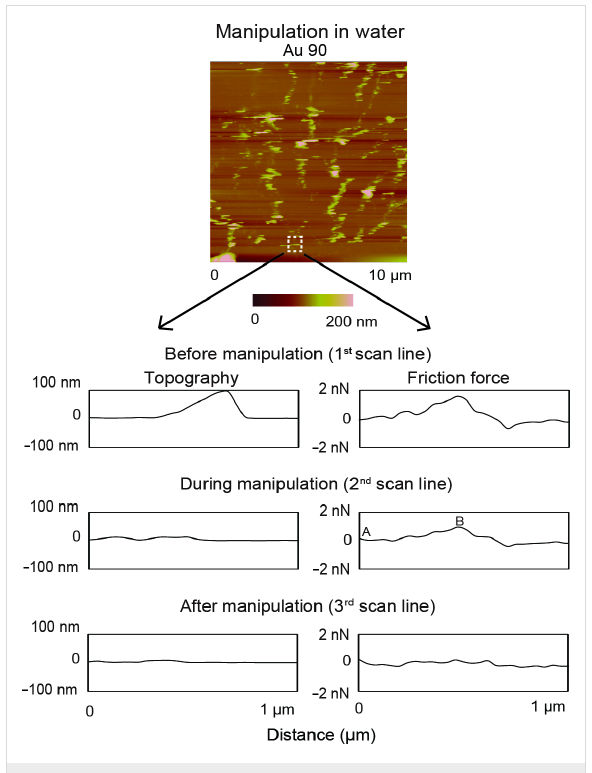
Figure 7: Topography map of Au (90 nm in diameter) nanoparticle submerged in water. Imaging is performed by using a cantilever with a low normal load of 1 nN. The highlighted particle is examined and the associated topography and friction force scan lines before manipula- tion, during manipulation and after manipulation are show. Before manipulation there is a rise in friction force corresponding to the particle profile as the cantilever deflects during imaging. During manip- ulation the topography profile is flat as the nanoparticle is being pushed, which corresponds to a rise in friction force (A–B). After manipulation, both the topography and friction force profiles remain flat as the nanoparticle is no longer